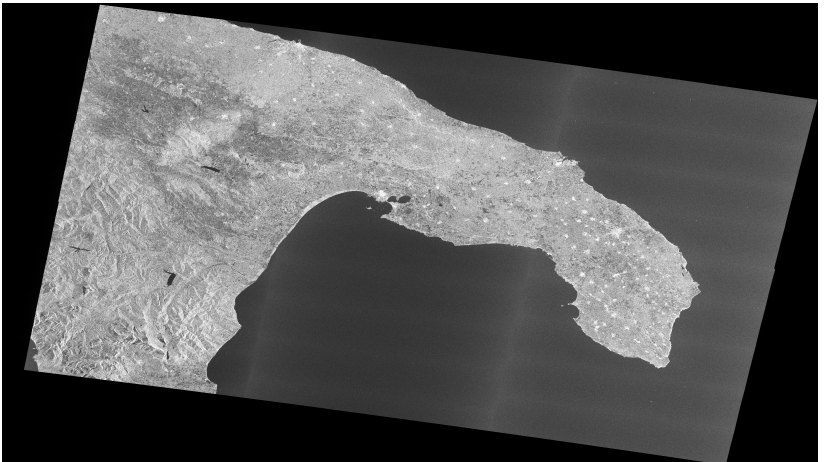
Figure 2. High resolution images Level-1 Ground Range Detected product acquired in interferometric wide swath mode by Sentinel-1 platform on the 7 June